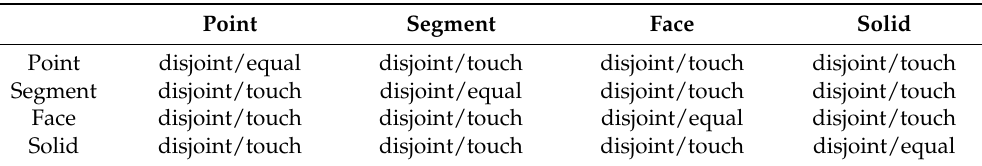
Table 1. Classes of topological relations for 3-D cadastral